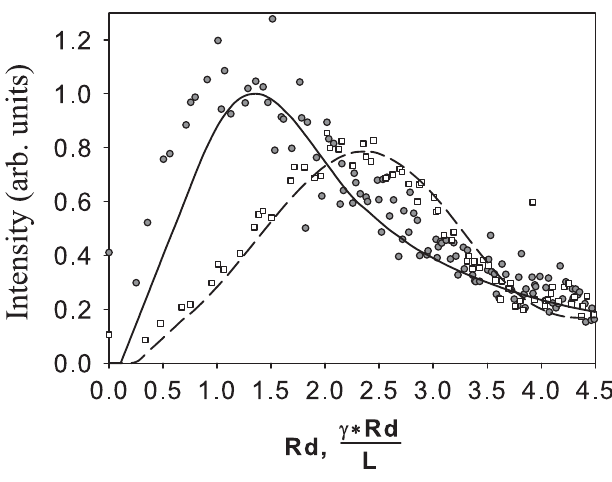
11. The radial distribution of the total OTR intensities. Gray dots—spherical target experiment; white squares—flat target experiment; solid line—spherical target theory; dashed line—flat target theory.